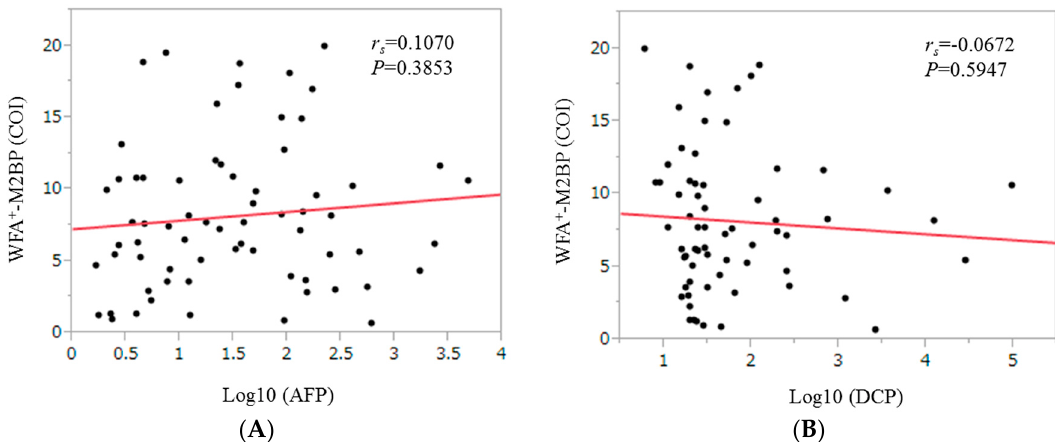
Figure 4. Correlation between WFA + -M2BP level and tumor markers (alpha-fetoprotein (AFP) ( A ) and des- γ -carboxy prothrombin (DCP) ( B )) for HCC